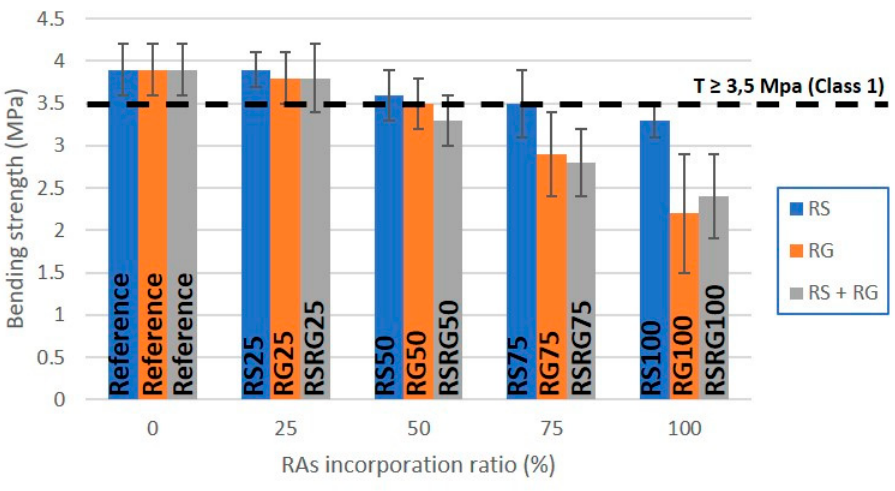
Figure 7. Graphical representation of bending strength vs. RAs’ incorporation ratio in Figure 7 . Graphical representation of bending strength vs. RAs’ incorporation ratio in kerbs.